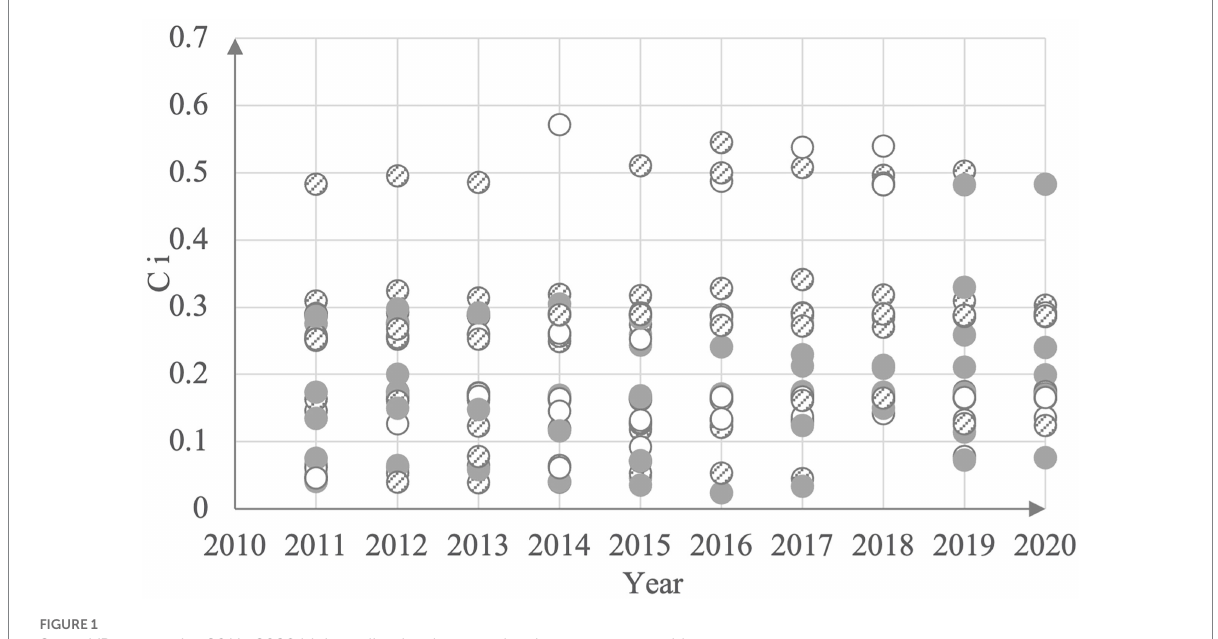
FIGURE 1 Some VR companies 2011–2020 high quality development level measurement table.